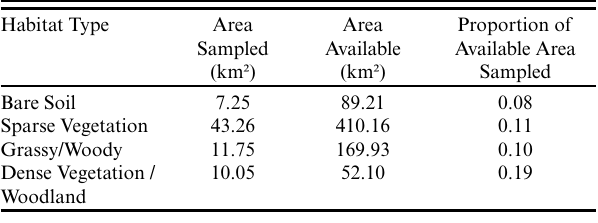
Table 1 . Proportion of habitat types sampled compared to overall amount of habitat type determined from vegetation layers in ArcGIS (version 10.3.1) within the Northern Tuli Game